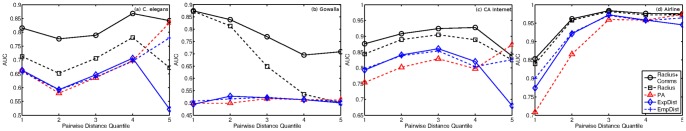
AUC measured over separate quantiles of the test data, split by the pairwise distance between the nodes for which a link is being predicted.The quantiles are shown on the x-axis, where 1 contains all node-pairs that are close together, and 5 contains those that are separated by the greatest distances.